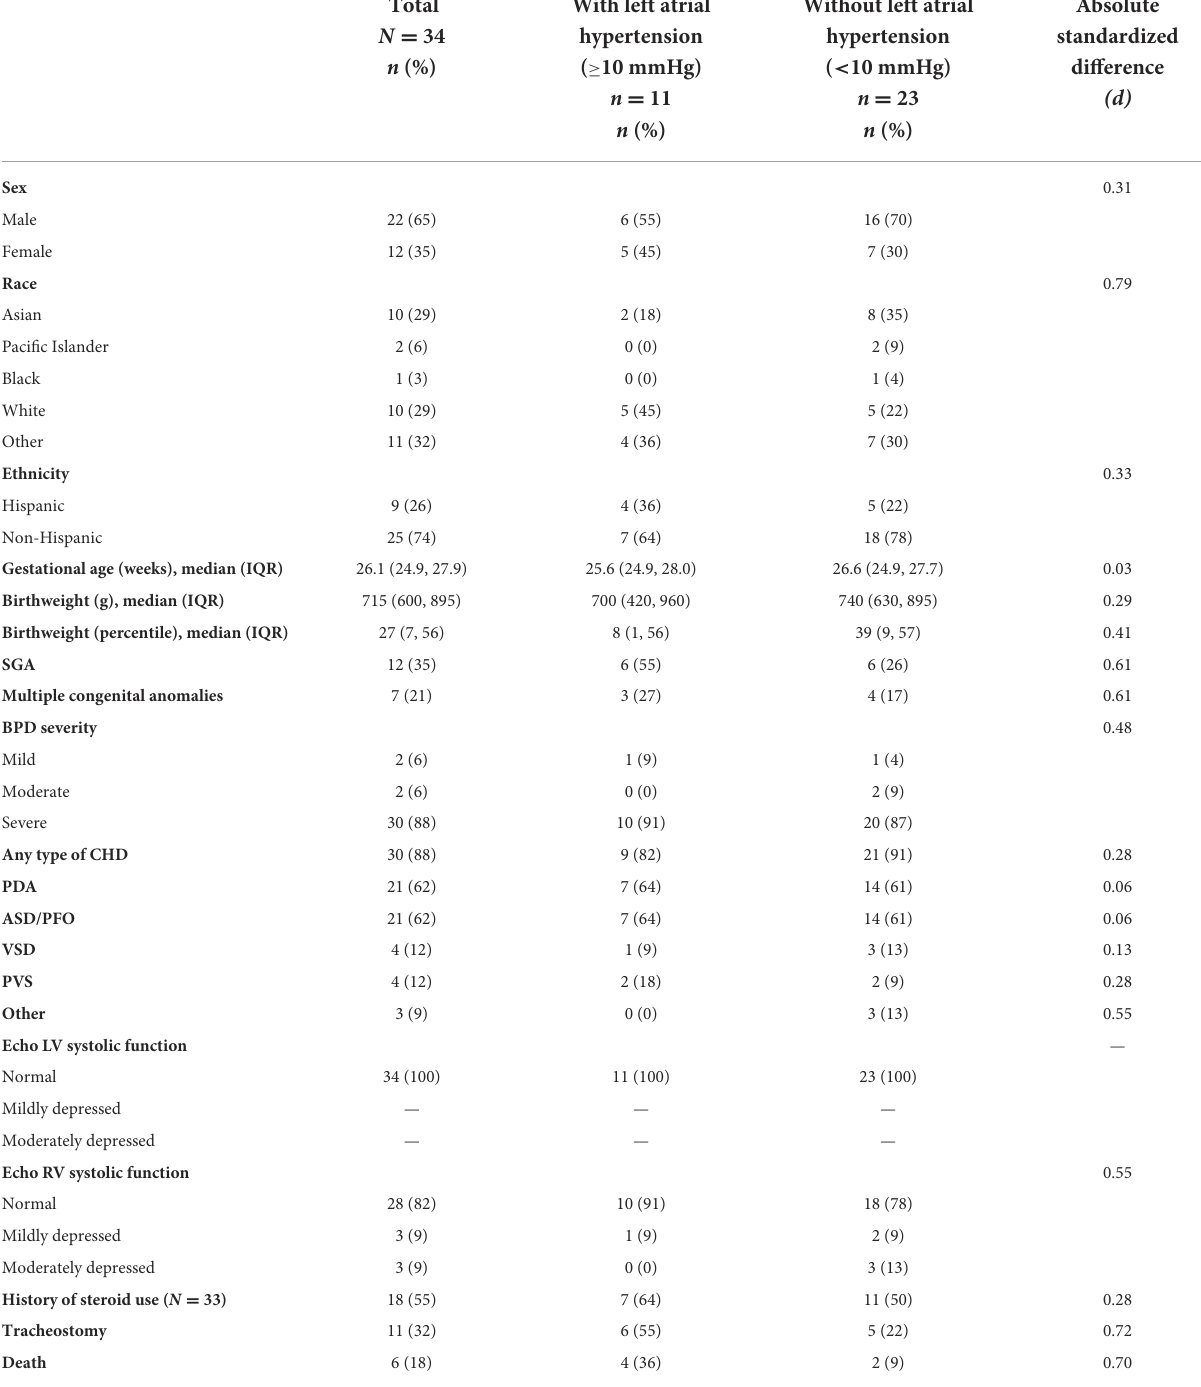
TABLE 1 Patient demographics and clinical characteristics ( N =